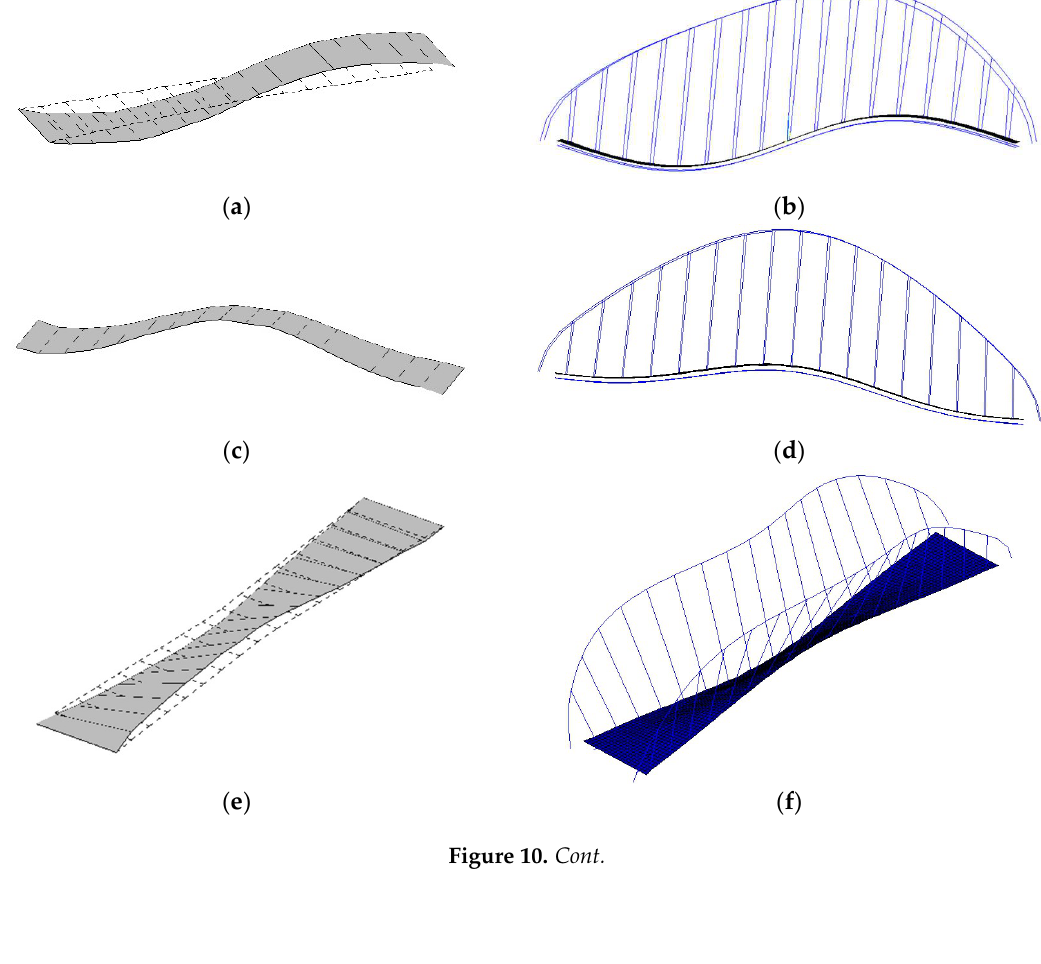
Figure 9. Mode dominated by the arch: ( a ) the 1st mode (0.93 Hz); ( b ) the 2nd mode (0.99 Hz); ( c ) the 5th mode (2.50 Hz); ( d ) the 8th mode (5.22 Hz).